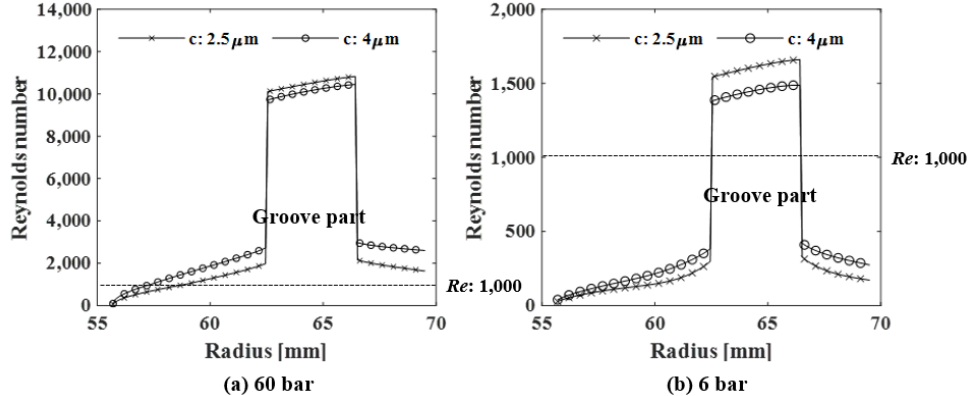
Figure 9. Pressure due to the laminar, turbulent, and slip conditions of the fluid film at an outer pressure of 6 bar.